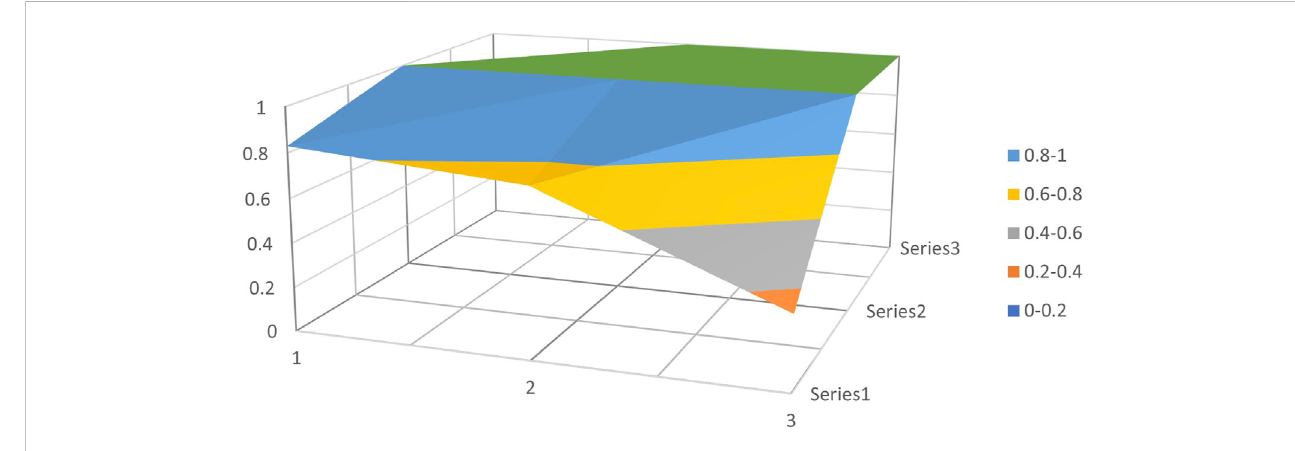
FIGURE 5 PMC surface of P 2